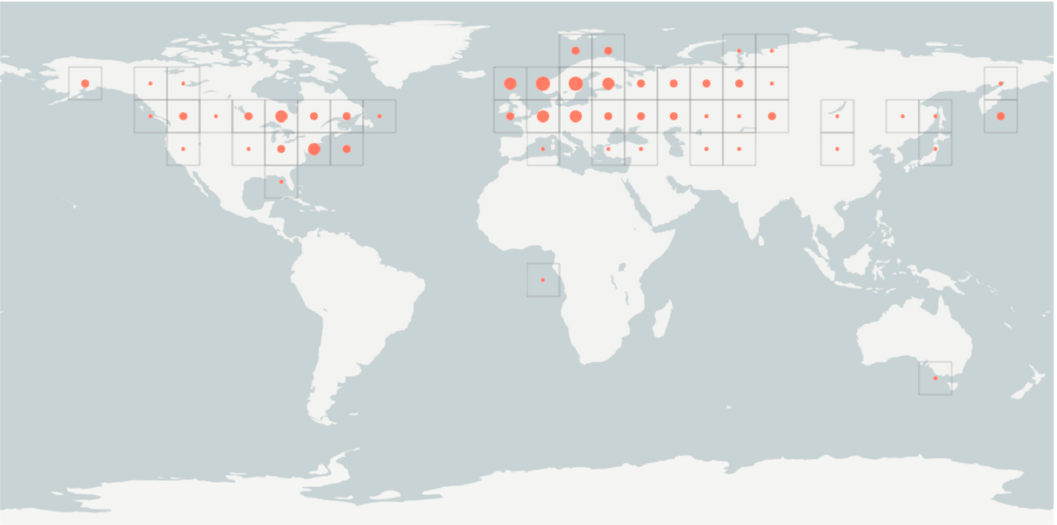
Figure 1. Global Geographical distribution of Inonotus obliquus in the circumboreal regions. These health benefits of Chaga are also due to its high myco-nutrient content [13].